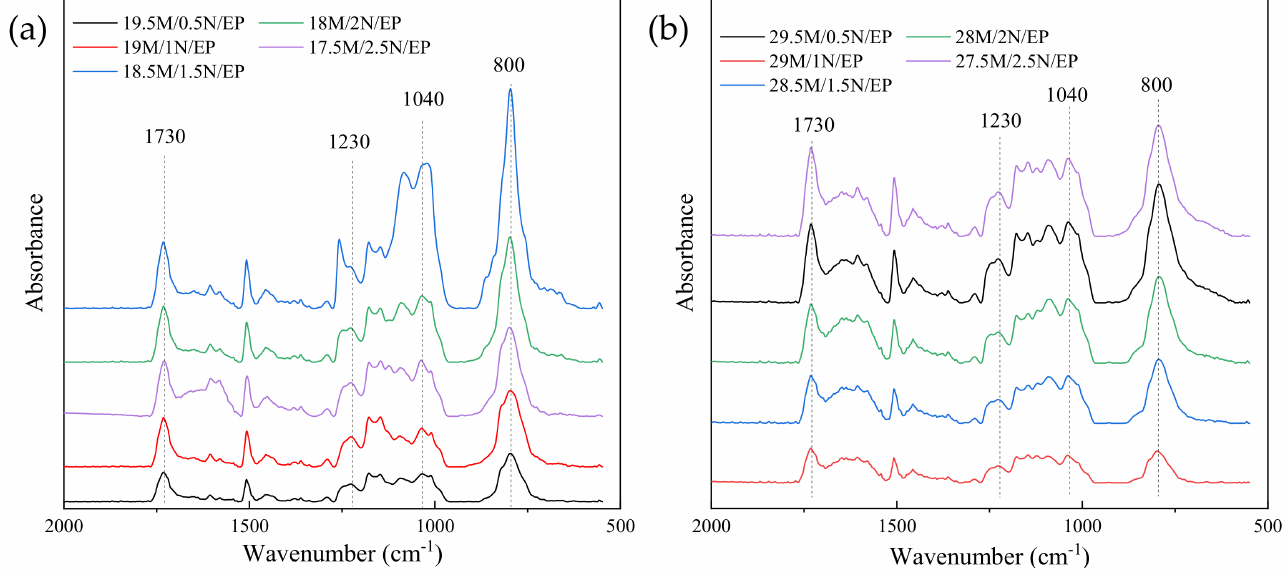
Figure 19. Partial enlarged view of baseline correction of the micro/nano SiC/EP infrared spectra. ( a ) 20 wt% SiC/EP; ( b ) 30 wt%